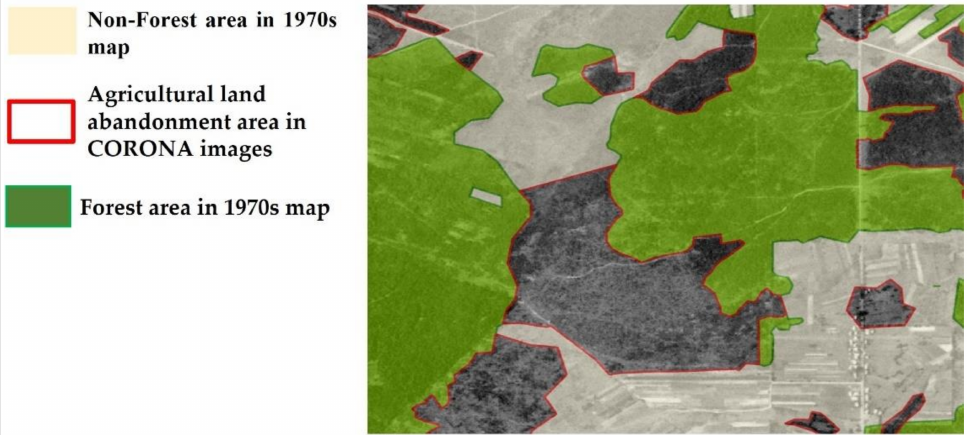
Figure 3. Detecting objects and backdating the historical map by CORONA imagery in Szydłowiec